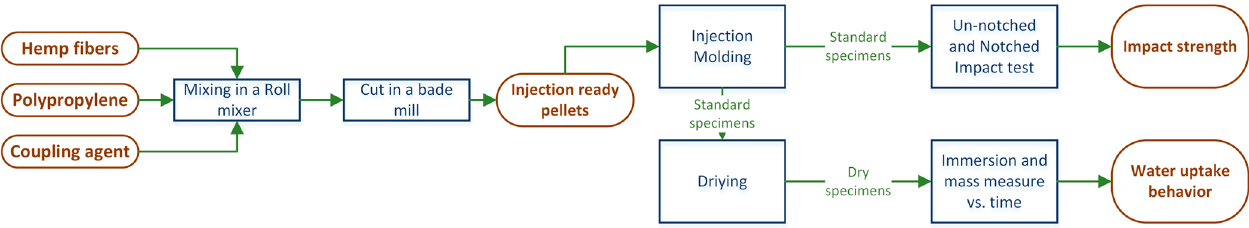
Figure 1. Flow-chart of the experimental methods in the current investigation.